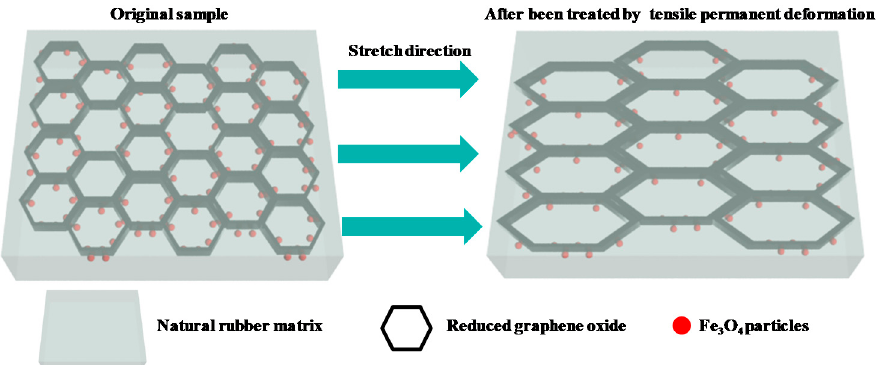
Figure 6. The change of the segregated network along the stretched direction after being treated by tensile permanent deformation of MGNR composites.